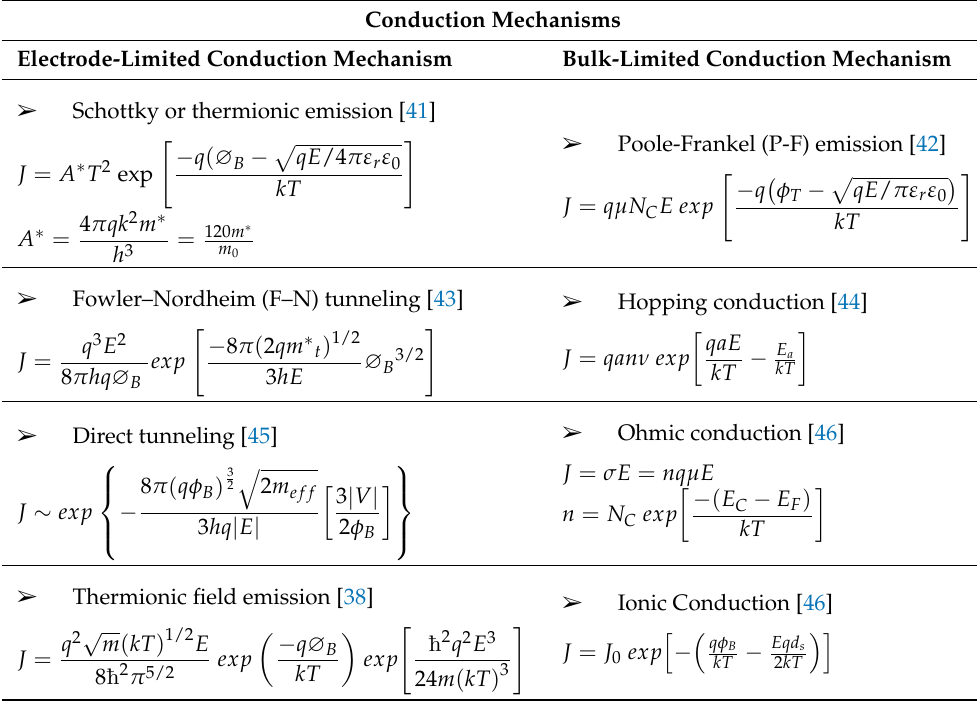
Figure 5. An illustration showing the rGO is placed on top of copper electrodes to form a sensing element. Table 1. Classification of the conduction mechanisms and their